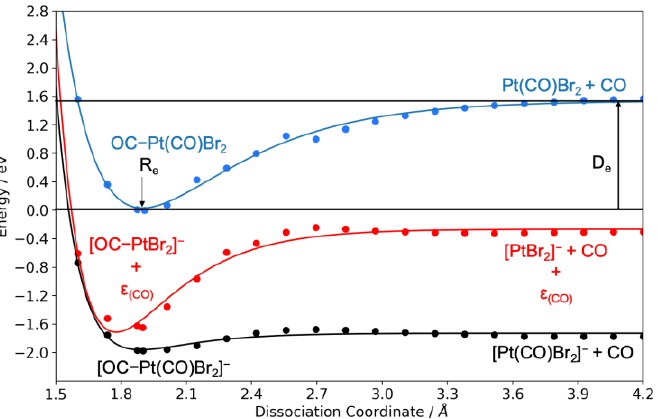
Figure 2. Relaxed potential energy surface scans for OC−Pt(CO)Br 2 dissociation from the neutral parent and OC−Pt(CO)Br 2 and OC−PtBr 2 dissociations from the respective anion. The calculations were performed at wB97X-D3/ma-def2-TZVP level of theory.